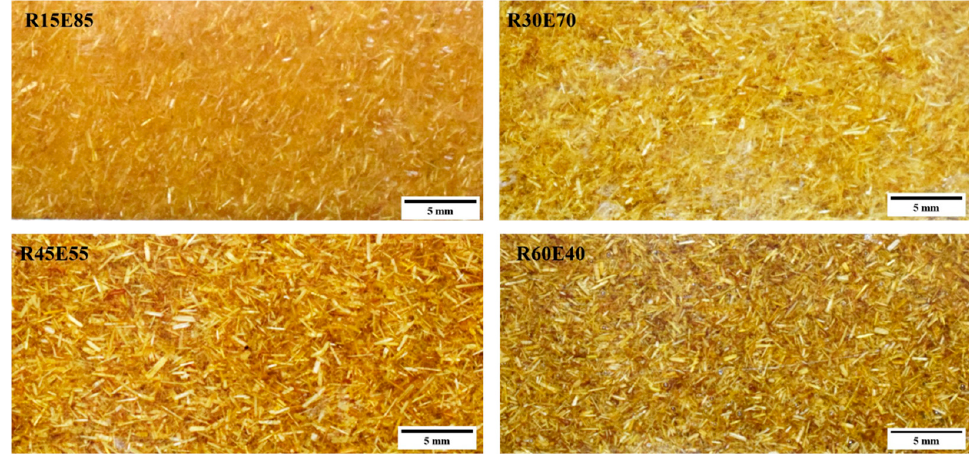
Figure 2. RS p -reinforced test samples.